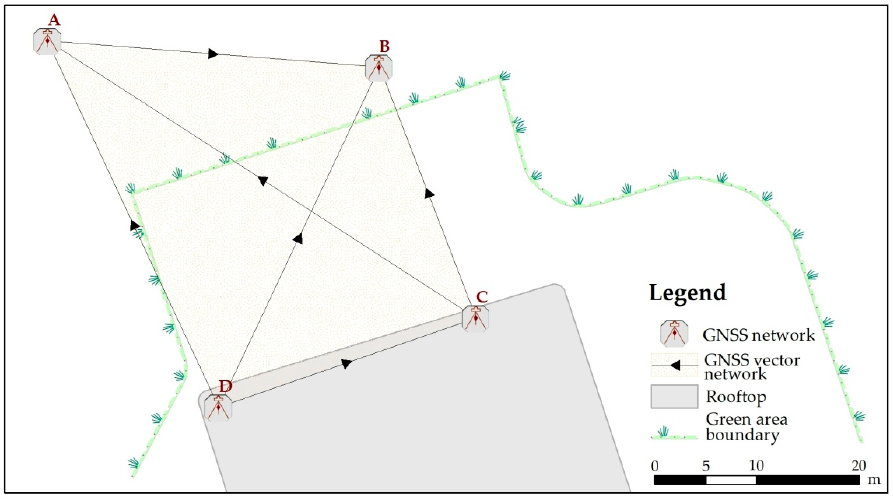
Figure 3. GNSS network.